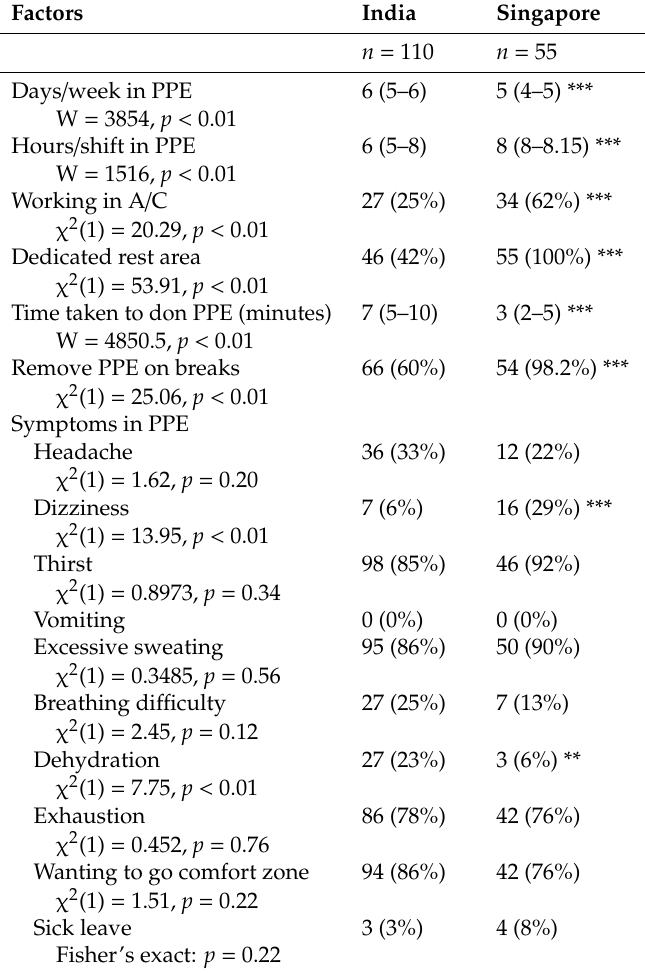
Table 2. Comparison of impact of PPE usage and related thermal stress, duration of usage, time taken for donning and do ffi ng the PPE, whether or not PPE could be removed during breaks, availability of dedicated rest areas, and symptoms experienced due to heat stress (W = Wilcoxon rank-sum test statistics, χ 2 = Pearson’s chi-square test statistics). Factors India Singapore n = 110 n = 55 Days / week in PPE 6 (5–6) 5 (4–5) *** W = 3854, p < 0.01 Hours / shift in PPE 6 (5–8) 8 (8–8.15) *** W = 1516, p < 0.01 Working in A /